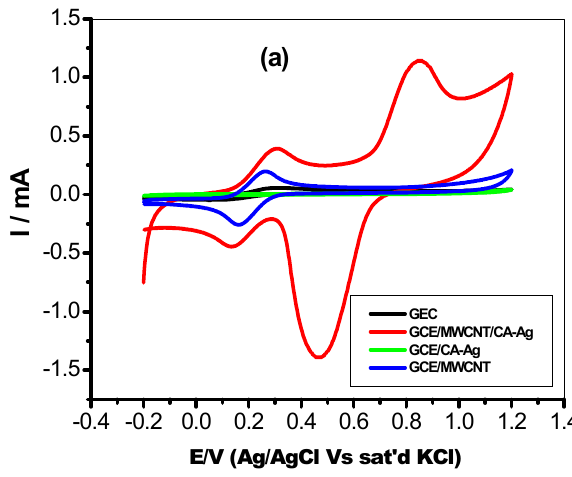
Figure 5. Cyclic Voltammograms of GCE/CA-Ag (green), bare GCE (black), GCE/MWCNT (blue), and GCE/CA-Ag/MWCNT (red) in 5mM Fe(CN) 6 ] 4 − /[Fe(CN) 6 ] 3 − solution prepared in 0.1 M PBS at scan rate 25 mVs − 1 .